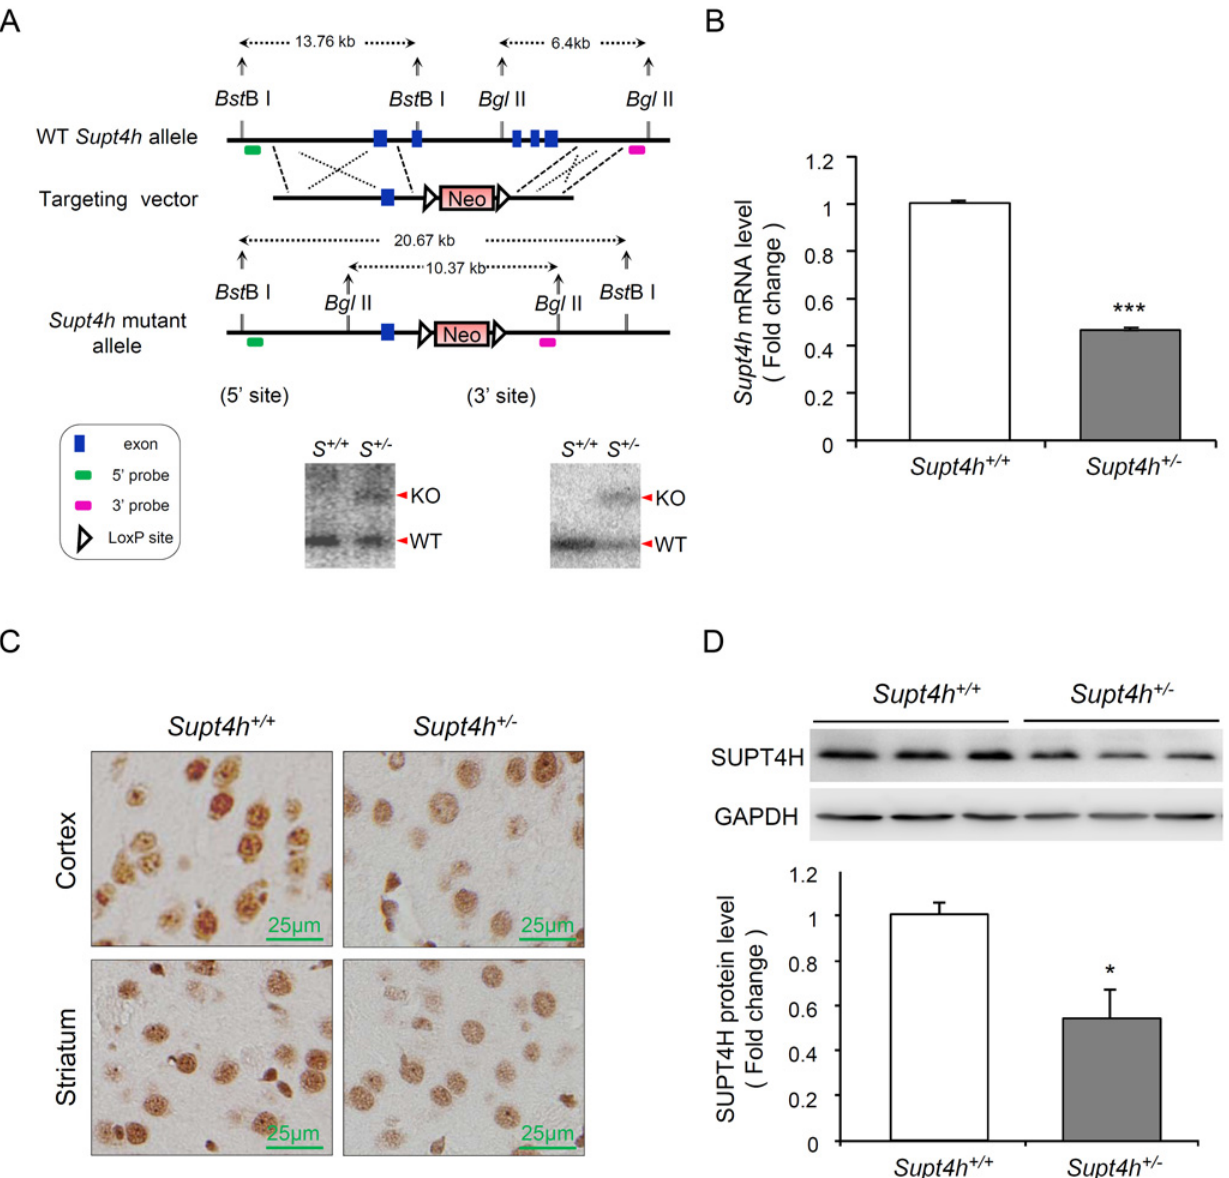
Fig 2. Creation and characterization of Supt4h knockout mice. (A) Genomic organization of the mouse Supt4h locus (Top) and structure of the targeting vector (Middle). In the allele carrying the Supt4h deletion, a neo cassette specifying resistance to the antibiotic G418 in animal cells replaced the DNA fragment encompassing exon 2 to exon 5 of Supt4h via homologous recombination (Bottom). Positions of 5 ’ and 3 ’ flanking probes used in Southern blot analysis, and predicted sizes of restriction fragments detected by these probes are shown. Genomic DNA of C57BL6/129 mice ( S +/+ ) and their Supt4h +/- ( S +/- ) littermates was subjected to Southern blot analysis using the 5 ’ and 3 ’ probes separately. (B) Supt4h mRNA levels were assessed by qRT-PCR using the brain tissue of Supt4h +/+ and Supt4h +/- mice. The abundance in Supt4h +/+ mice was set as 1, after normalization with U6 RNA. (C) SUPT4H protein level in the striatum and cortex of indicated mice was analyzed by immunohistochemistry (IHC) using antibody against SUPT4H. (D) Protein lysates collected from the cerebrum of indicated mice were analyzed by Western blot using anti-SUPT4H antibody. GAPDH served as loading control. Data are presented as the mean ± SEM (n = 3 in each group; * , p < 0.05; *** , p < 0.001 by Student ’ s t -test). The mice were sacrificed at the age of 12 weeks for analyses.